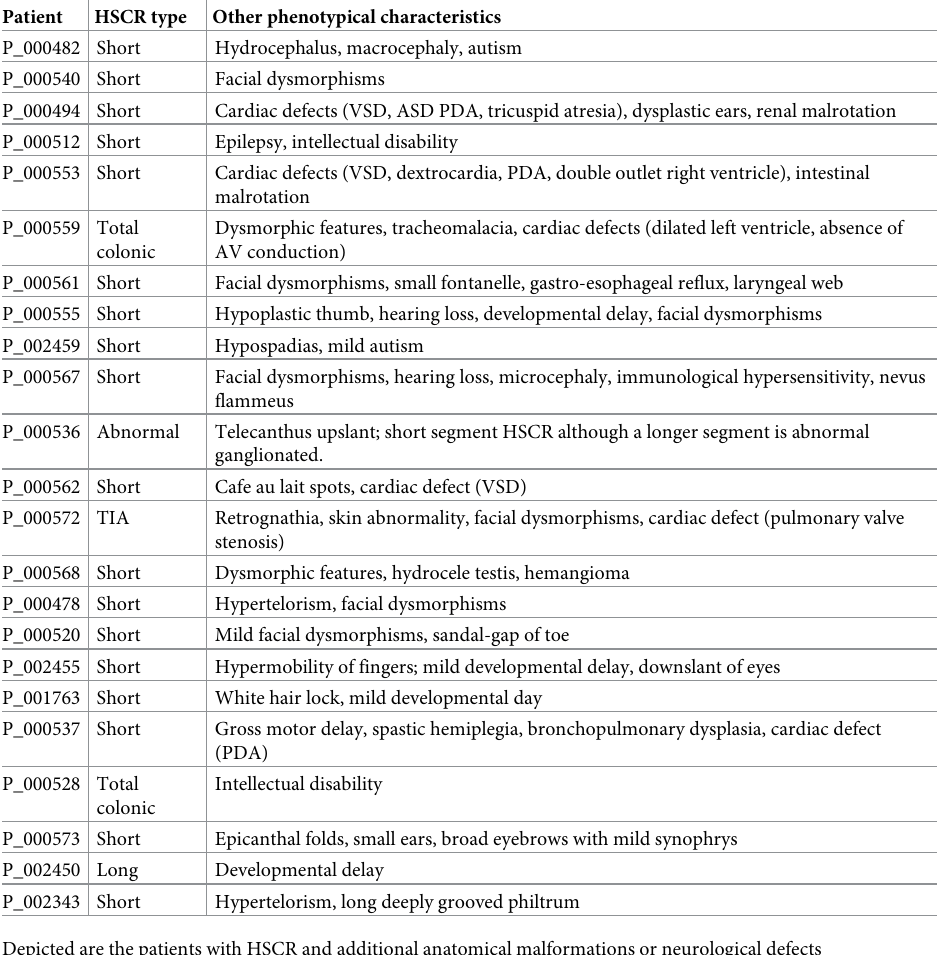
Table 1. Hirschsprung patients without a RET mutation and additional phenotypical